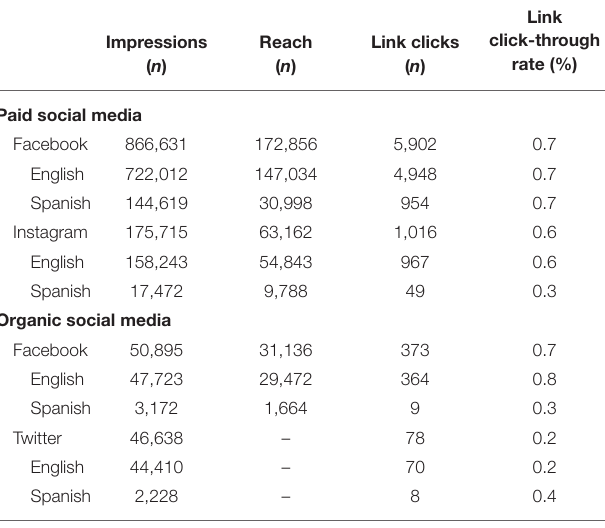
TABLE 2 | Overall performance for paid and organic social media.